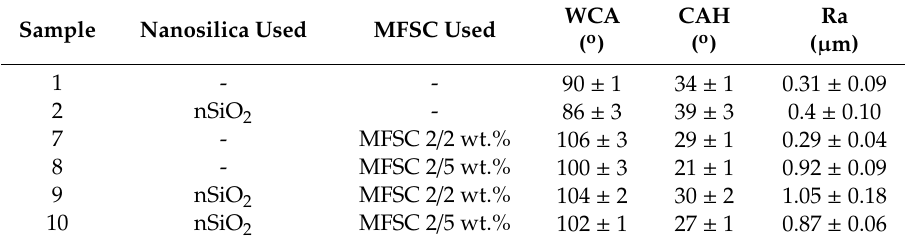
Table 3. Description and roughness of the samples with MFSC